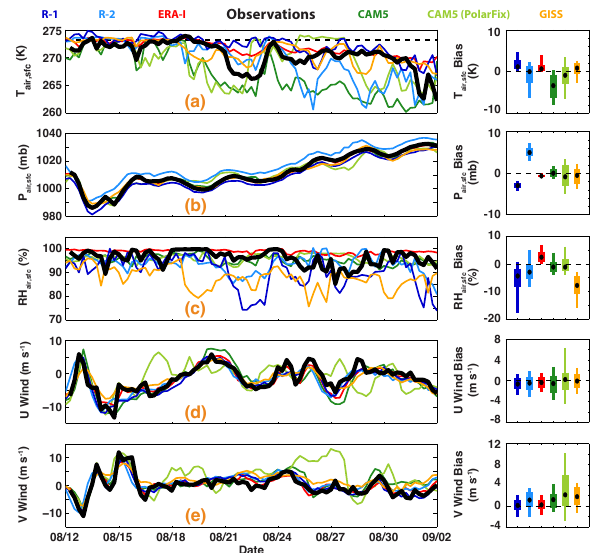
Fig. 2. Time series of basic meteorological quantities from top to bottom: surface air temperature, surface air pressure, surface air rel- ative humidity, 10m U wind component, and 10m V wind compo- nent. Included are lines for the observations from Oden (bold black line), CAM5 (standard version, dark green; CAM5-PF, light green), the GISS-ModelE2 (orange), and R-1 (dark blue), R-2 (light blue) and ERA-I (red) reanalyses. ERA-I, R-1 and R-2 lines represent 6- hourly analysis (0h) time instantaneous values, while the CAM5 lines depict the interpolated value for the analysis time from the model 1-hourly averages. The right-hand side of the figure includes distributions depicting the median (black dot), IQR (wide bar) and 10th–90th percentiles (thin bar) of the differences between simu- lated and observed